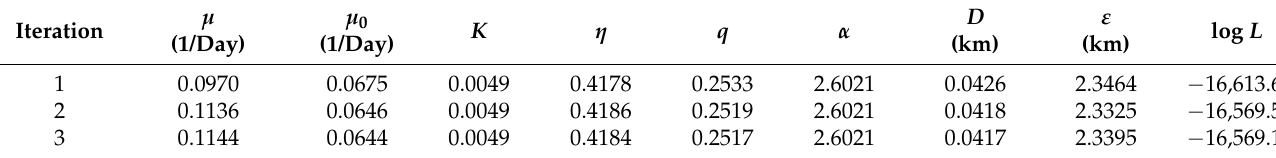
Table 1. Convergence steps of the fitted ETAS parameters for the study catalogue. Parameter α is fixed through the fitting. The value µ 0 is included for information and it reflects the daily frequency of background events within the core area A 0 . The preferred parameters are these from iteration